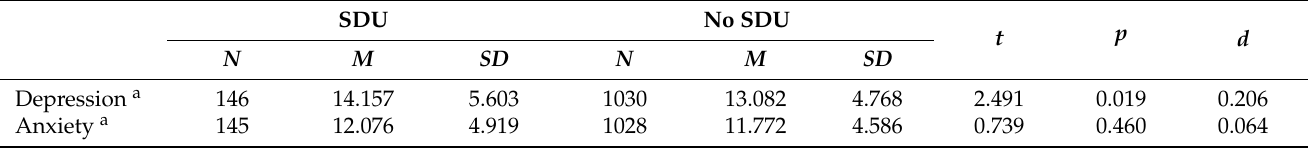
Table 5. Relationship Between SDU and Self-Reported Depression and